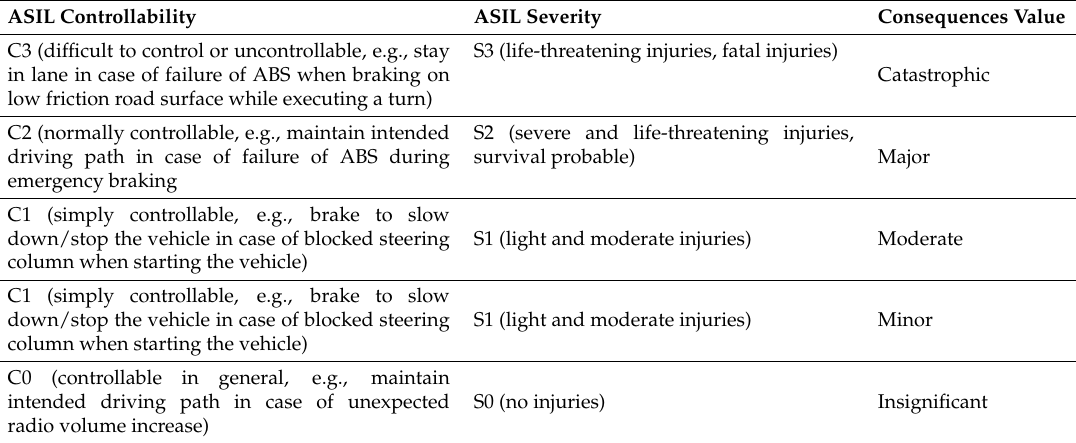
Table 12. Mapping Qualitative Consequences Scale for Vehicles to ASIL Severity and Controllability values.